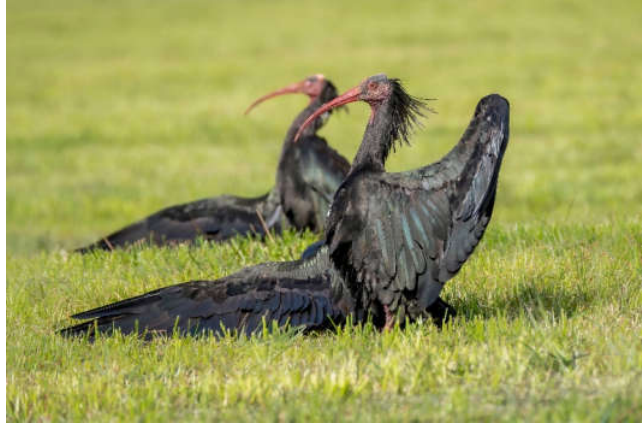
Figure 4. Sunning behaviour. Photo R. Beck.